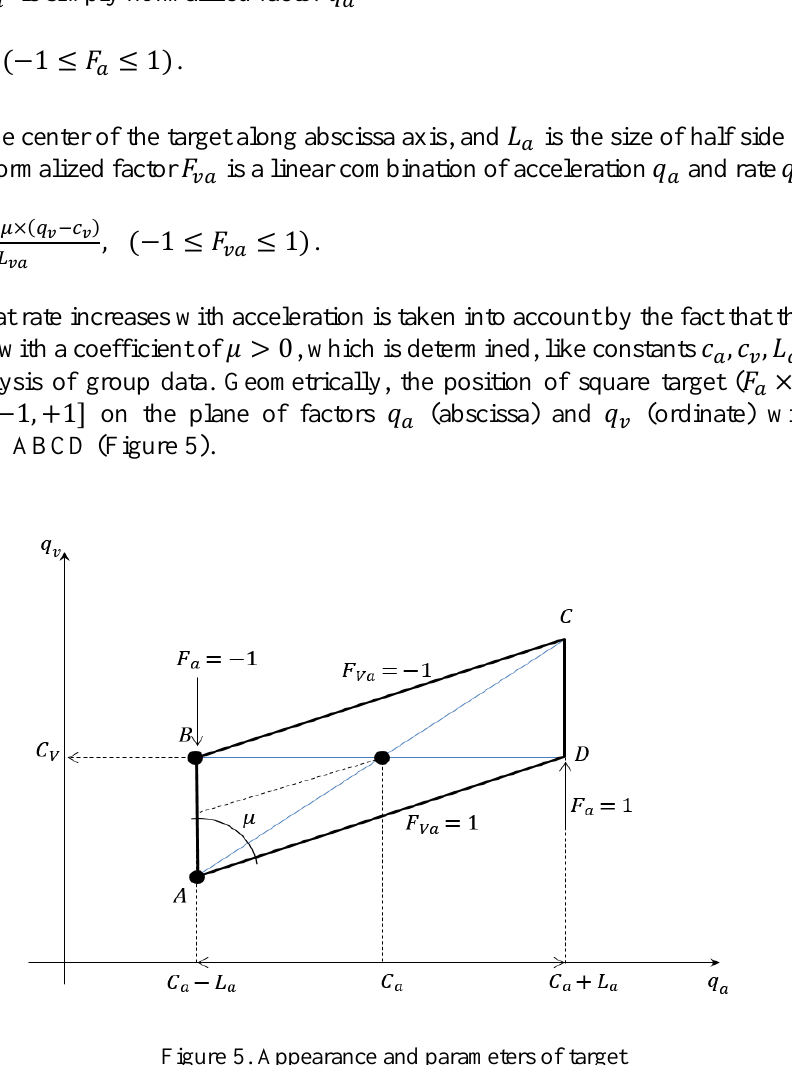
Figure 5. Appearance and parameters of